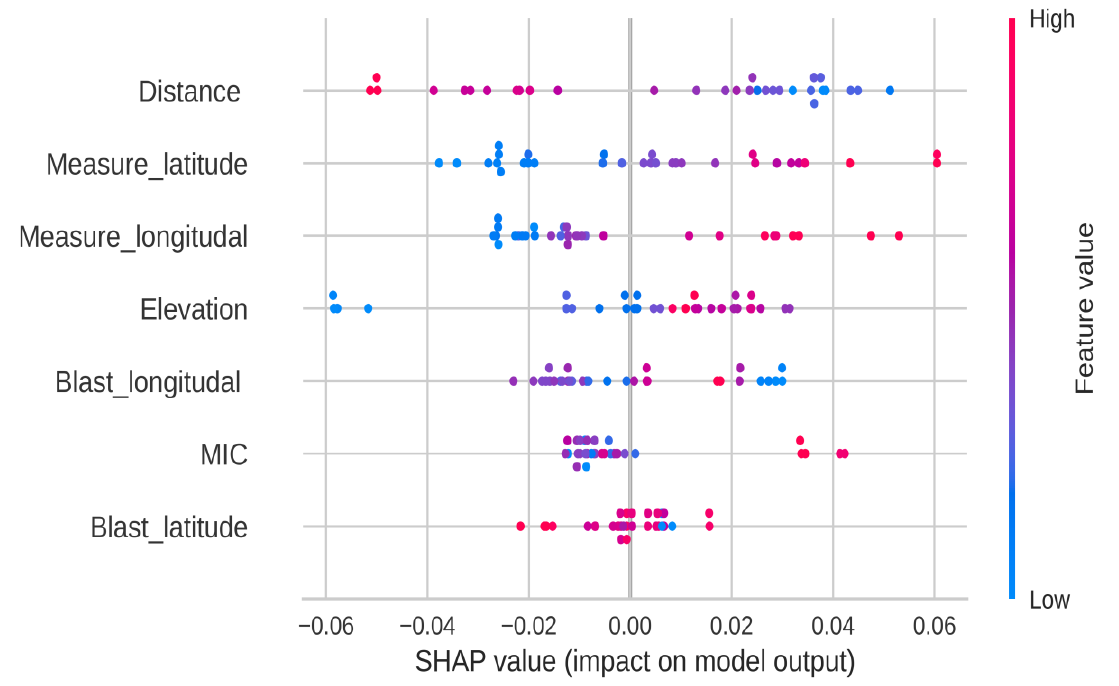
Figure 13. Feature importance of the model. Color scale: pink colors correspond to high importance of a feature, while blue colors denote low